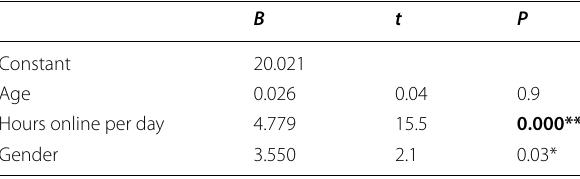
Table 6 Linear regression model for prediction of the score of internet addiction test: Internet Addiction Test